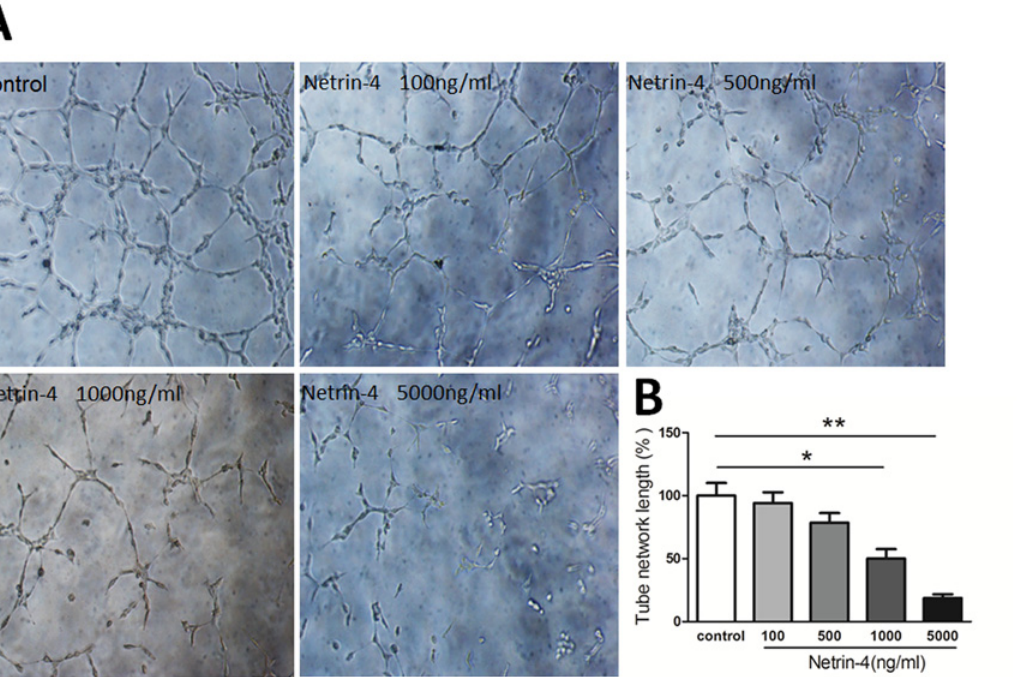
Fig 3. Effect of netrin-4 on HUVECs tube formation. Tube formation was assessed in tubulogenesis assay in vitro model, HUVECs were serum-starved with EBM2 medium (0.1% FBS, no growth factor) (Lonza) for 12 hours. HUVECs (1.5×10 4 ) were then cultured in a 24-well plate (Gibco) coated with 150 mL Matrigel Basement Membrane Matrix GFR (BD Biosciences). Different concentrations of netrin-4 (100, 500, 1000, and 5000 ng/mL) or PBS (control) were added, and the results were quantified 6 h later using Image J. (B) Representative images out of three independent experiments are shown. * p < 0.05; ** p < 0.01. Each experiment was performed three times and representative pictures are shown. Data are expressed as mean ± SD.